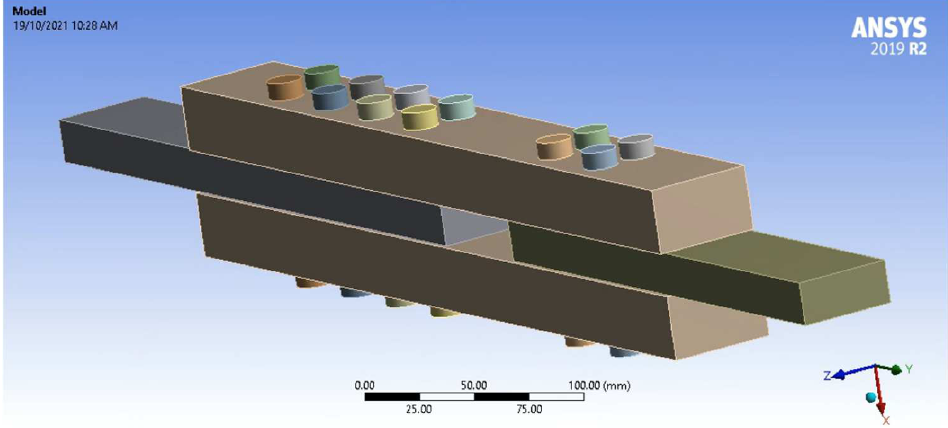
Figure 13. Unconfined Simulation